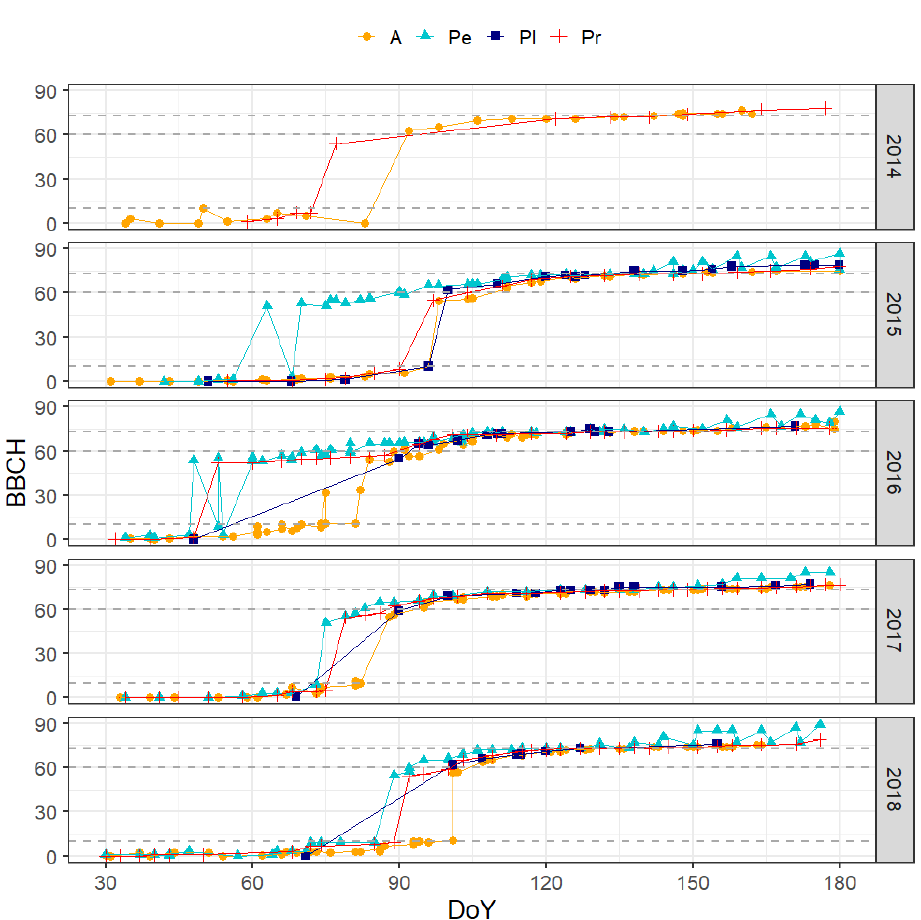
Figure 3. Observed phenological stages in BBCH scale of different fruit types and variety during the period 2014–2018 averaged over the 12 stations (A—apple “Ajdared”, “Golden Delicious”; Pe—peach, Pl—plum; and Pr —pear “Kaludjerka”, “Santa Maria”, “Viljamovka”).